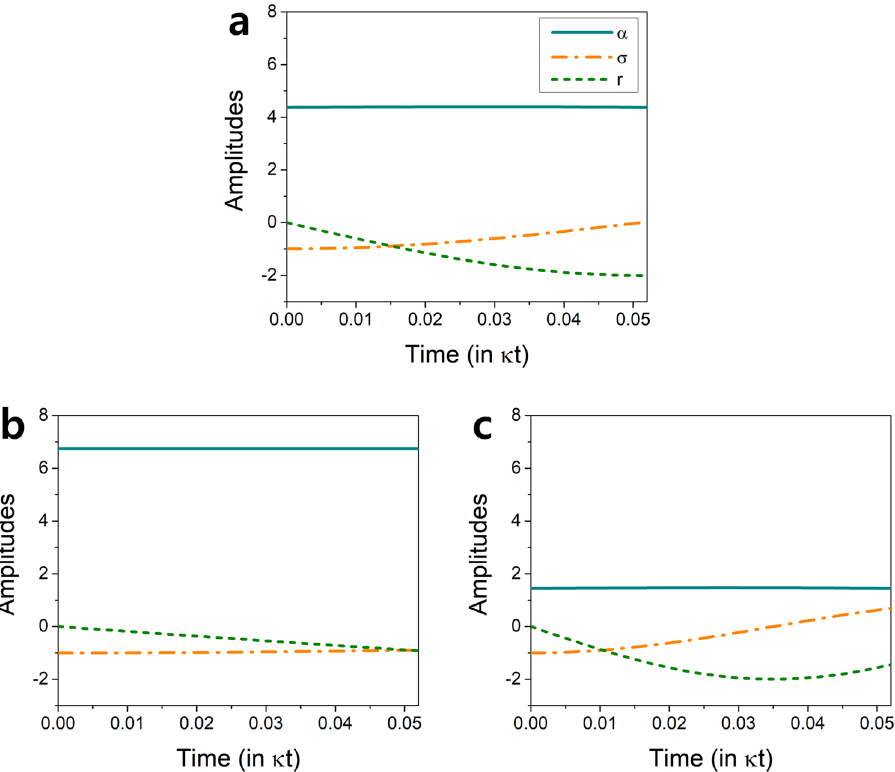
Figure 4. Origin of hyperradiance on resonance. ( a ) Evolution of α , σ and r during the atom-cavity interaction 0, g /κ 3.5 and N 0.052 when � 2 . The solution α corresponds to the steady-state time τ with κτ = = = = 19 . This condition corresponds to the α(τ) . ( b ) The same for �/κ solution of Eq. (5), satisfying α( 0 ) = = 19 . For � > 0 , the variation of σ is minimized, staying close to yellow points in Fig. 6. ( c ) The same for �/κ = − α its initial value and thus the atomic polarization is maximized, leading to a large . When � < 0 , on the other | | 0 , minimizing the polarization and making α hand, σ varies more than that for (cid:31) stay = | |